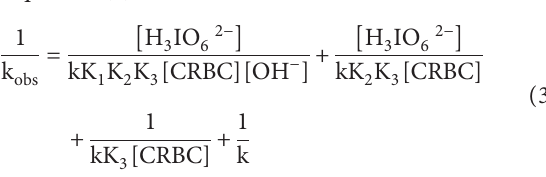
3 − u vs.[H 2 IO 6 ]